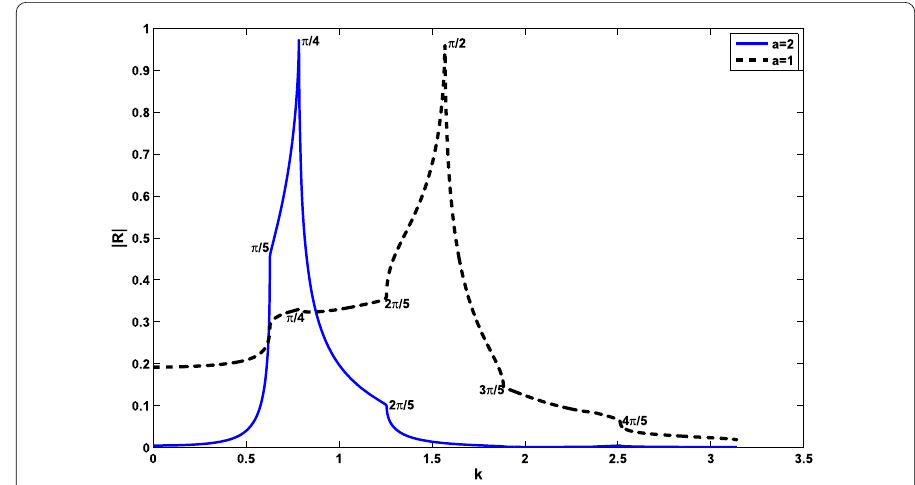
Figure 3 Reflected field amplitude | R | versus the wave number k for b = 3 and d = 5.